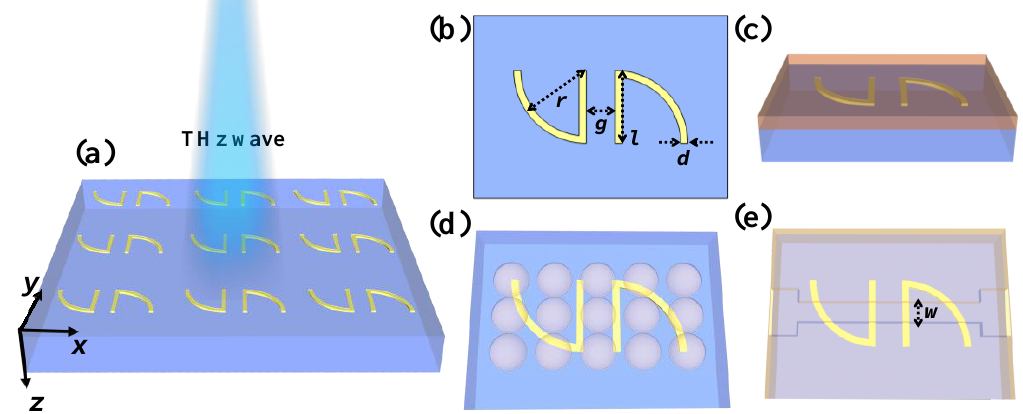
Figure 1. ( a ) Schematic drawing of the sickle-shaped metamaterial (SSM). ( b ) Geometrical denotations for the corresponding SSM unit cell. ( c – e ) Schematic drawings of SSM covered with ( c ) analyte thin-film, ( d ) dielectric hemispheres and ( e ) microfluidic channels.